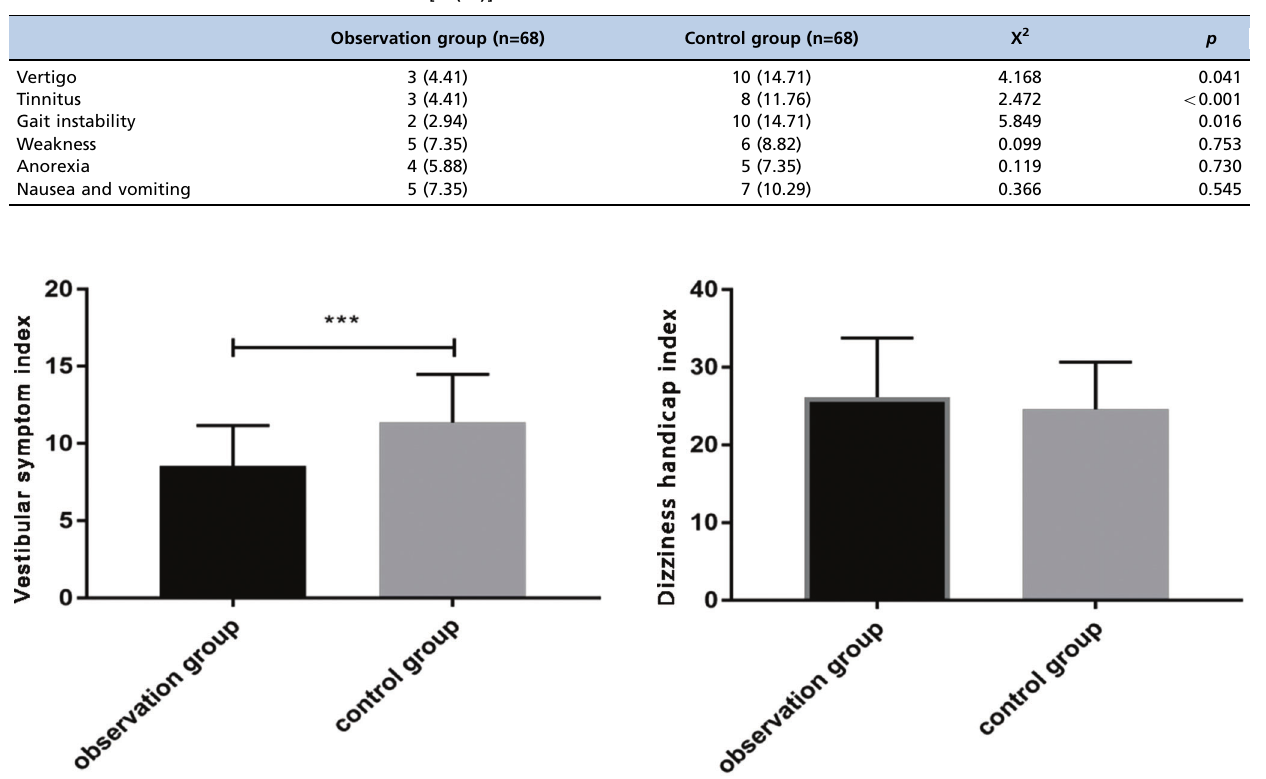
Figure 2 - Dizziness handicap index (DHI) score after treatment. After treatment, there was no significant difference in DHI score between the observation and control groups (t=1.324, p